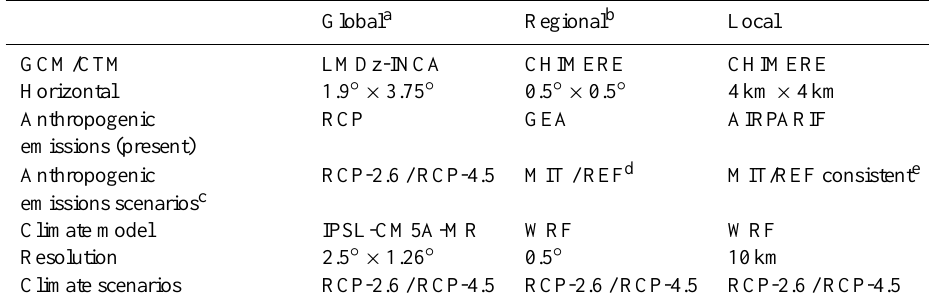
Table 1. Configuration description of the global, regional and local simulations of the present study. Global a Regional b Local GCM/CTM LMDz-INCA CHIMERE